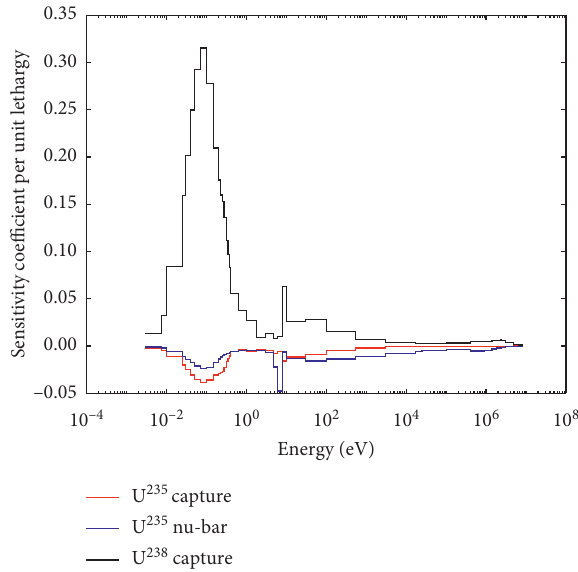
Figure 6: Sensitivity profiles of most important contributor to uncertainty of k -inf, PWR pincell